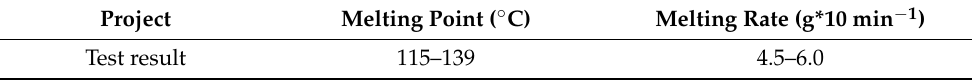
Table 3. Basic Physical Properties of RPP. Figure 3. Waste PP modifier.